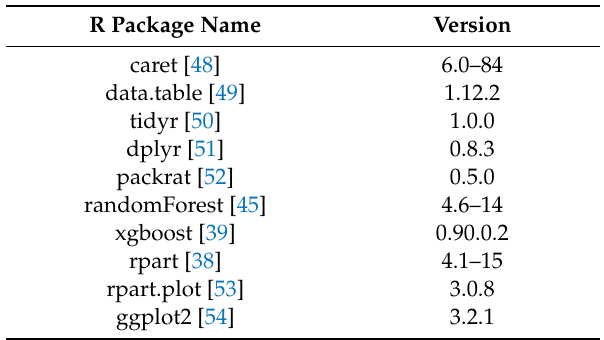
Table A1. R packages.